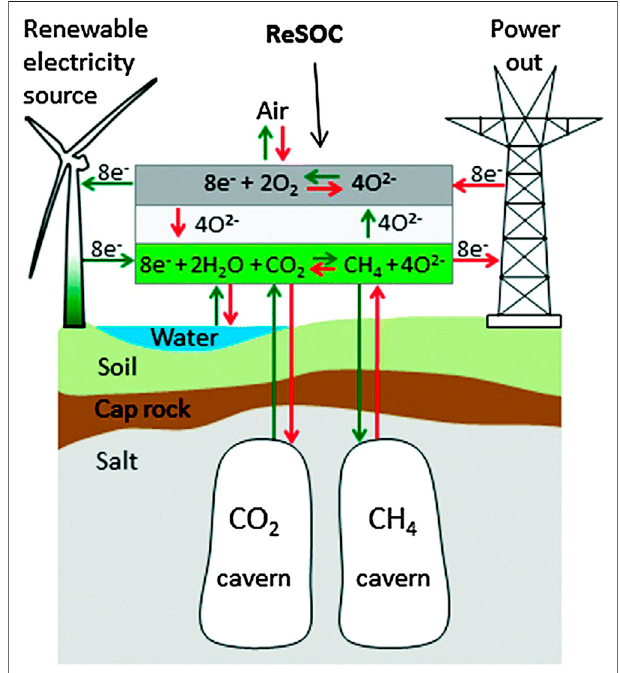
FIGURE 1 | Schematic diagram of the proposed large-scale electricity conversion and storage